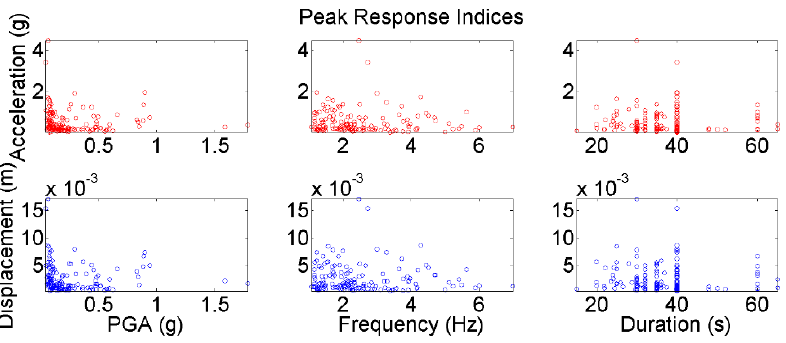
Figure 11. Peak responses indexed according to the strong motion parameters.